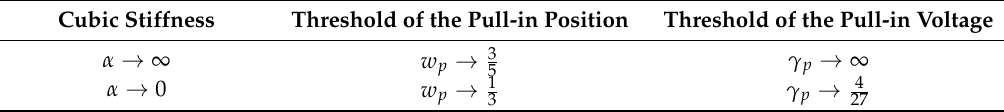
Table 1. Theoretical thresholds of the static pull-in position and pull-in